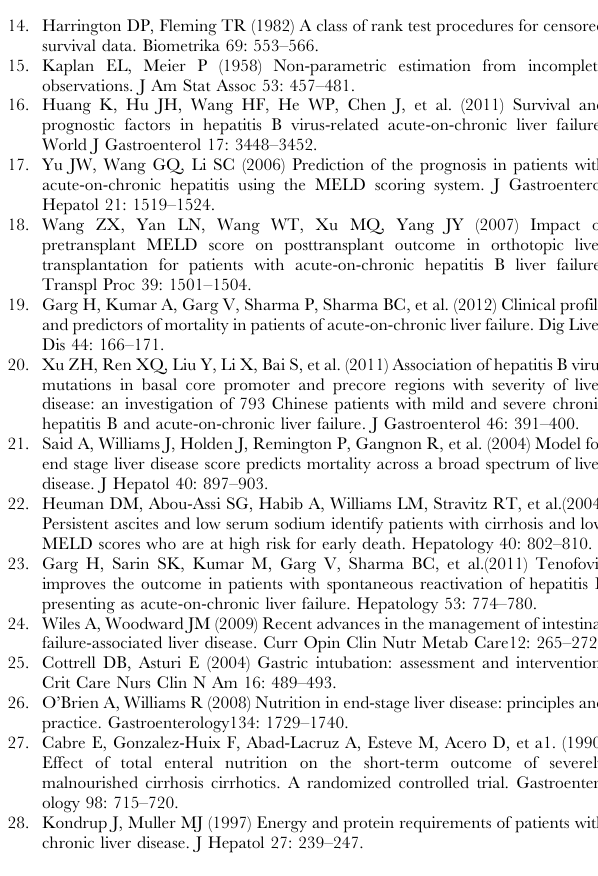
Table S2 Demographic, clinical, biochemical and he- patic-hemodynamic features in the training and valida- tion cohorts. Abbreviations: Abbreviation: ACLF, acute-to- chronic liver failure; INR, international normalized ratio; CTP, Child–Turcotte–Pugh scoring system; MELD, model for